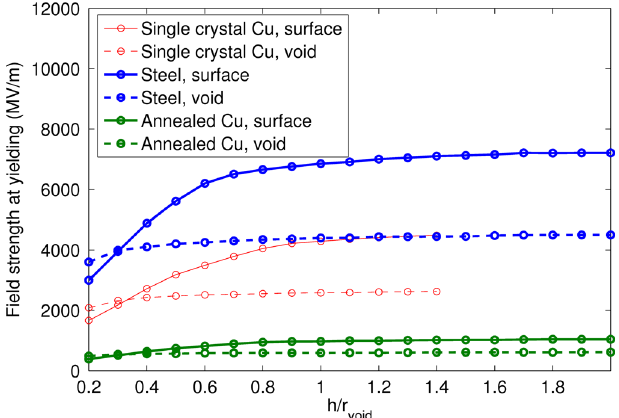
FIG. 8. External electric field at which the stress at the material (solid lines) and the void (dashed lines) surfaces reach the yield stress as a function of the void aspect ratio for the stainless steel, the single copper and the annealed copper surfaces containing